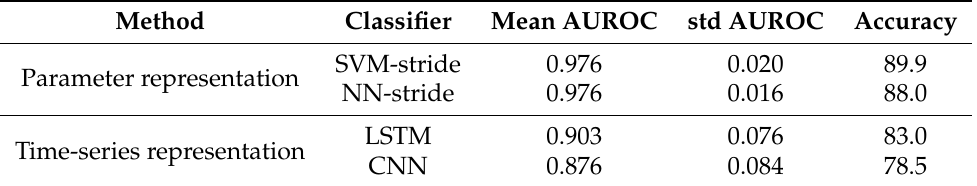
Table 5. The table lists the area under the receiver operating characteristic curves (AUROC) for all four classifiers: support vector machine (SVM-stride), feedforward neural network (NN-stride), long short-term memory neural network (LSTM) and convolutional neural network (CNN). Mean AUROC values and standard deviation (std) values have been calculated over 60 cross-validation